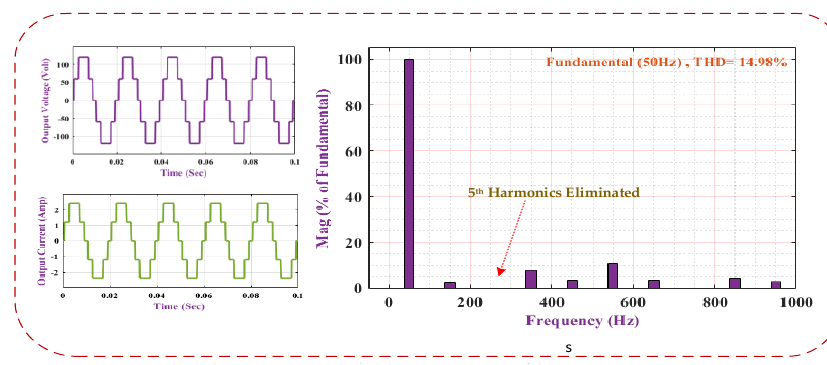
Figure 11. Five-level outputs and the harmonic profile.